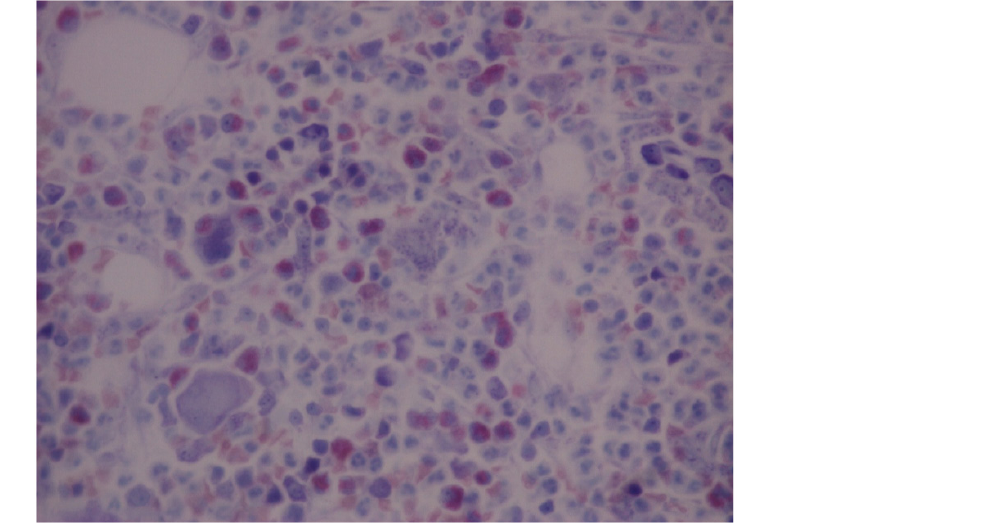
Figure 4. Bone marrow aspiration Leishman – Donovan bodies within